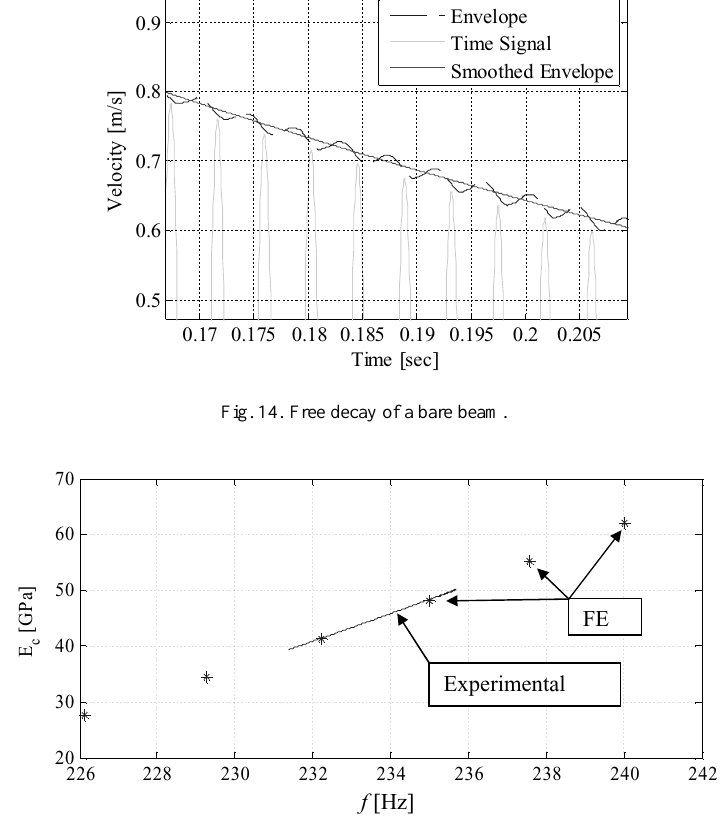
Fig. 15. Variation of coating modulus vs natural